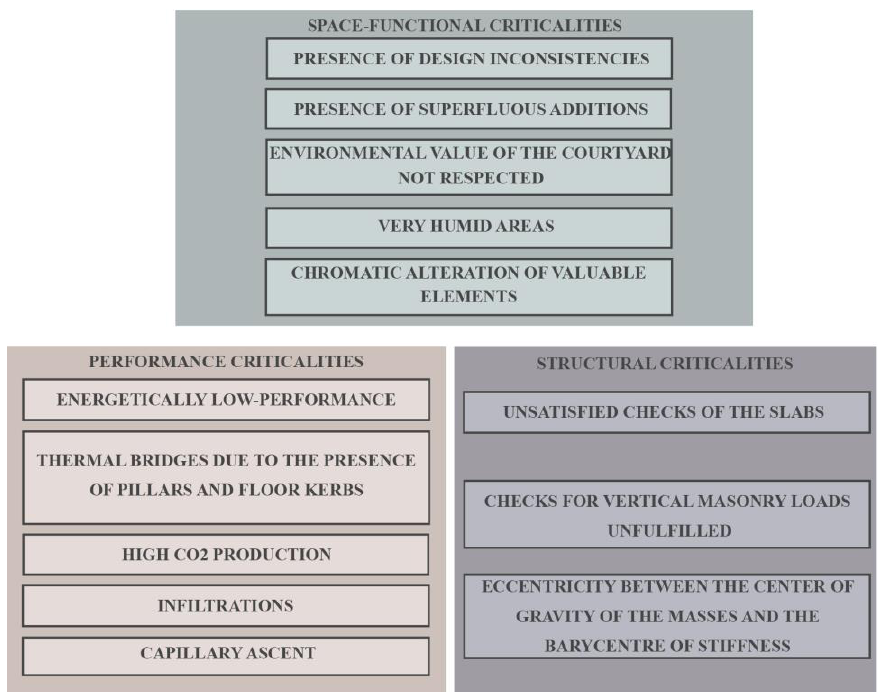
Figure 16. Three macro-categories of criticality.